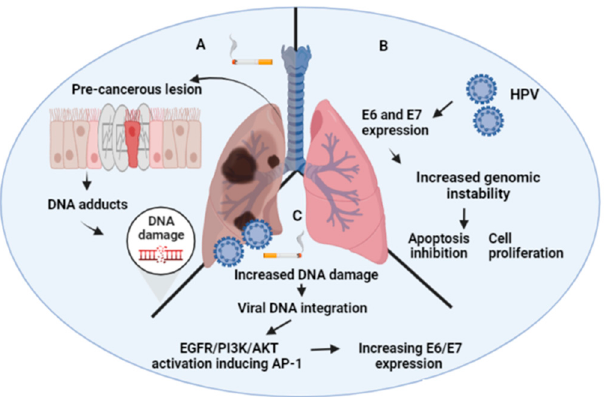
Figure 1. Tobacco smoke and HPV in lung cancer. ( A ) Tobacco smoking is the most important independent etiological factor of lung cancer. ( B ) HPV can be related to lung cancer as an inde- pendent carcinogen in non-smoker subjects. ( C ) HPV can cooperate with tobacco smoke for lung tumorigenesis). Designed using